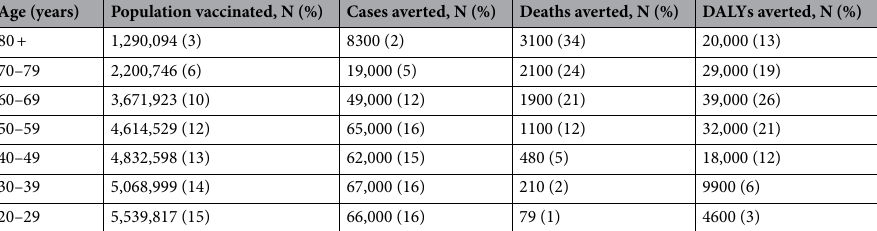
Table 2. Simulated impact of targeting COVID-19 vaccinations by age. *Excludes residents of long-term care facilities (skilled nursing facilities and assisted-living